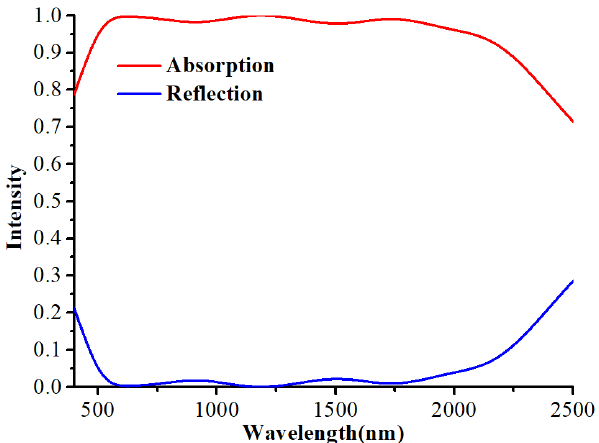
Figure 3. Absorption and reflection spectra under x-polarized plane waves.